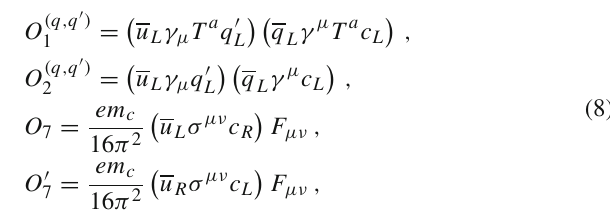
where Q u = 2 / 3 denotes the electric charge of the up-type quarks, and we decomposed P = v m D . The nonperturbative parameter λ D ∼ (cid:16) QCD is poorly known and thus source of 0 . 1 GeV [4]. For the final states π + π − γ and K + K − γ , the ( s ) can be expressed in remaining form factors f P 1 P 2 ( q , q (cid:7) )